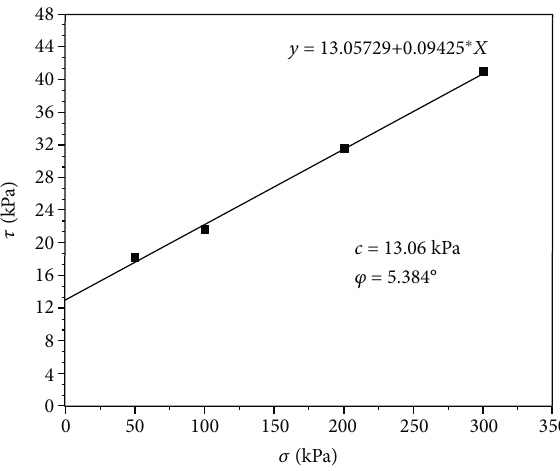
Figure 11: The curve of shear strength and vertical pressure.